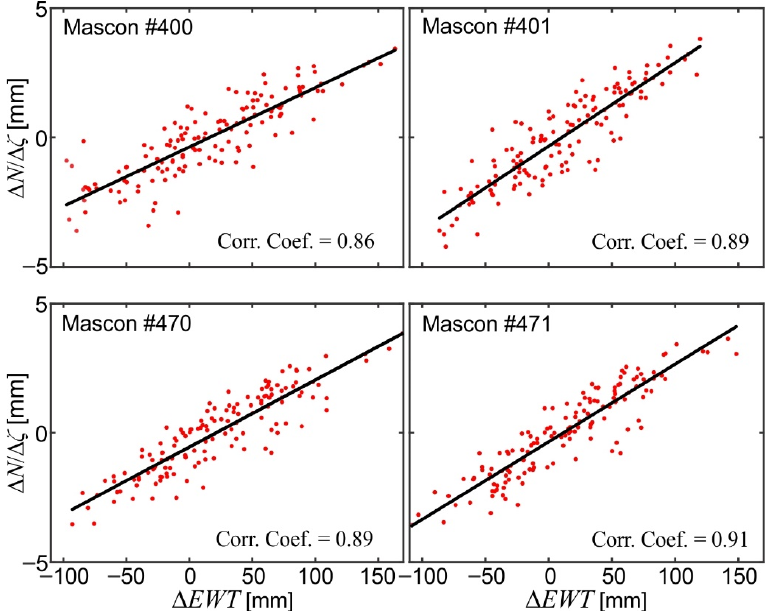
Figure 7. Correlations between temporal variations of equivalent water thickness ( Δ EWT ) and geoid/quasigeoid changes ( Δ N / Δ ζ ) over Poland.